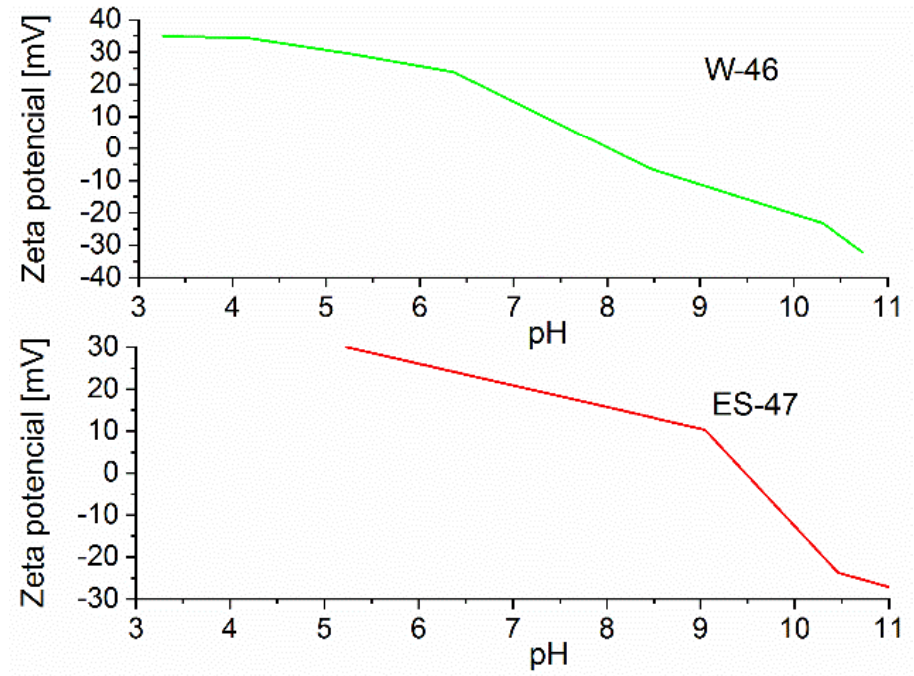
Figure 3. Surface charge of γ -alumina supports W-46 and ES-47.